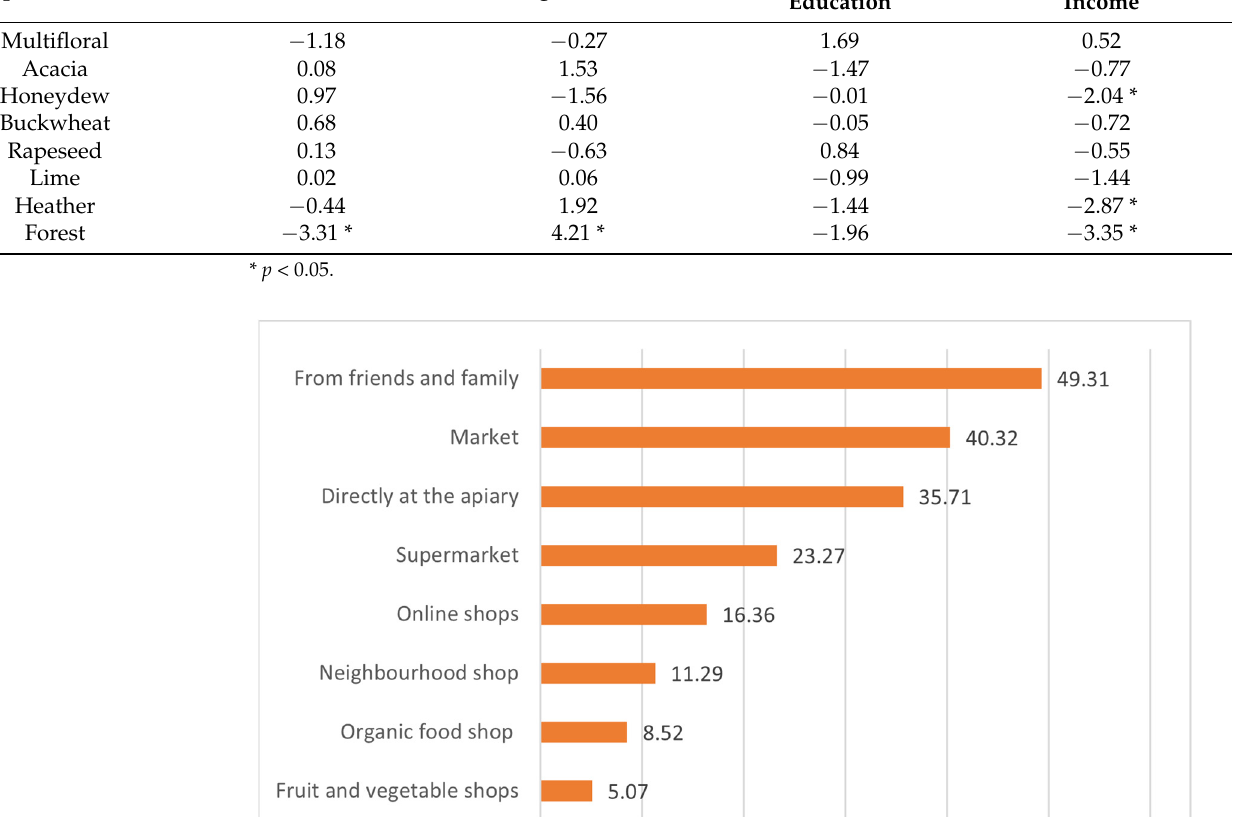
Table 4. Determinants of respondents’ preference for honey type ( n = 434, Mann–Whitney test).